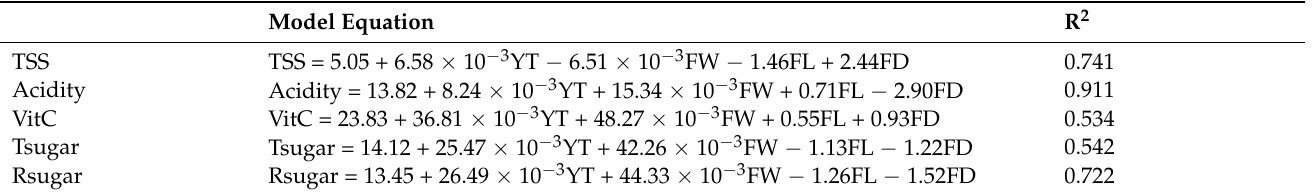
Figure 6. Relative error for the ANN and MLR models using the total soluble solids (TSS), acidity, vitamin C (VitC), total sugars (Tsugar), and reducing sugars (Rsugar) data during the testing process. Table 7. Equations derived from the MLR models for total soluble solids (TSS), acidity, vitamin C (VitC), total sugars (Tsugar), and reducing sugars (Rsugar). Model